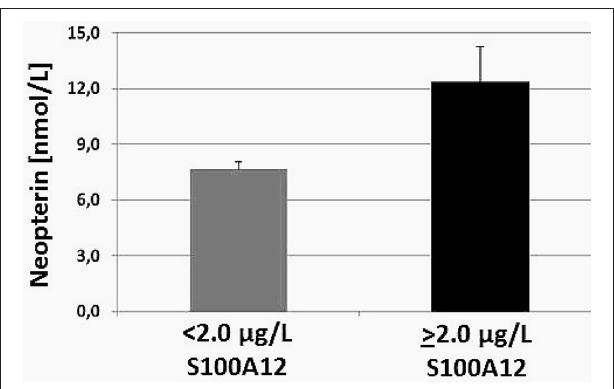
FIGURE 1 | Serum neopterin concentration (mean ± SEM) in patients suffering from cognitive decline grouped according to fecal S100A12 concentrations ( p < 0.001), modified from Leblhuber et al.